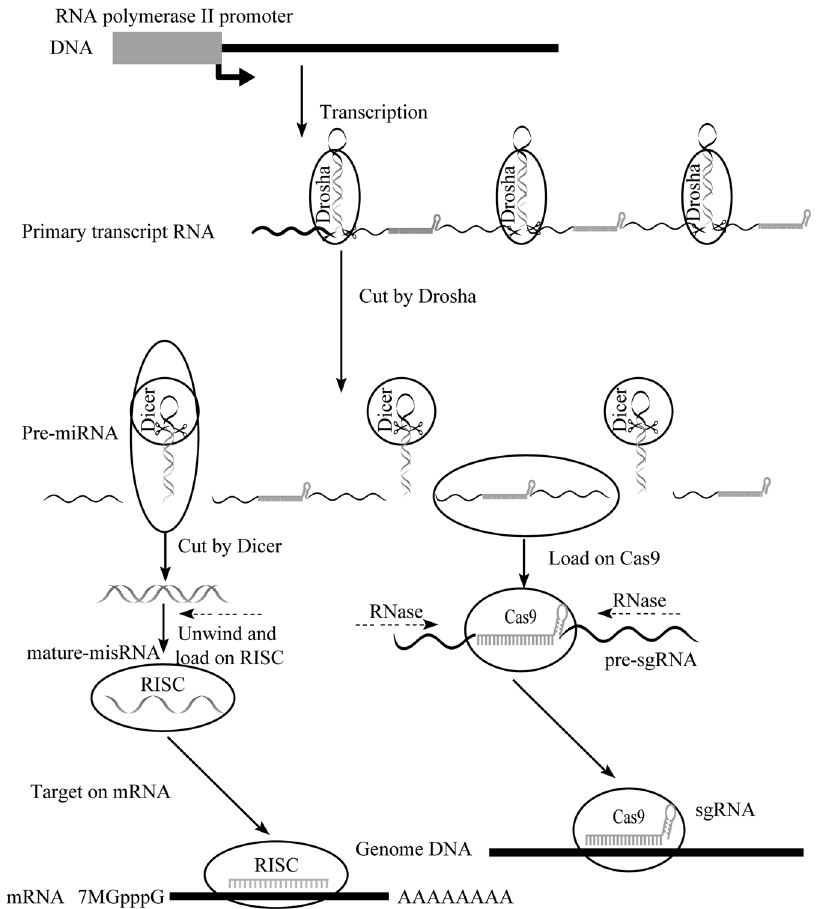
Figure 2. Schematic overview of the miRNA-based CRISPR vector construction system for multiplex genome engineering. In this construction miRNAs (or shRNAs) and sgRNAs alternately emerge in a polycistron. 5 ′ and 3 ′ arm of miRNAs (or shRNAs) were required for Drosha to recognize and cut the pri-miRNAs (or pri- shRNAs) from the original transcription. Pre-miRNA (or pri-shRNAs) can be transported into cytoplasm then cut by Dicer to form a double stranded RNA. Further, these double stranded-RNAs can be loaded onto RISC complex and function as a mature miRNA (or siRNA) to target on its corresponding mRNA. Simultaneously, sgRNAs bind to Cas9 (including dCas9-VP64, dCas9-KRAB, etc.). Redundant nucleotides can be degraded by ubiquitous